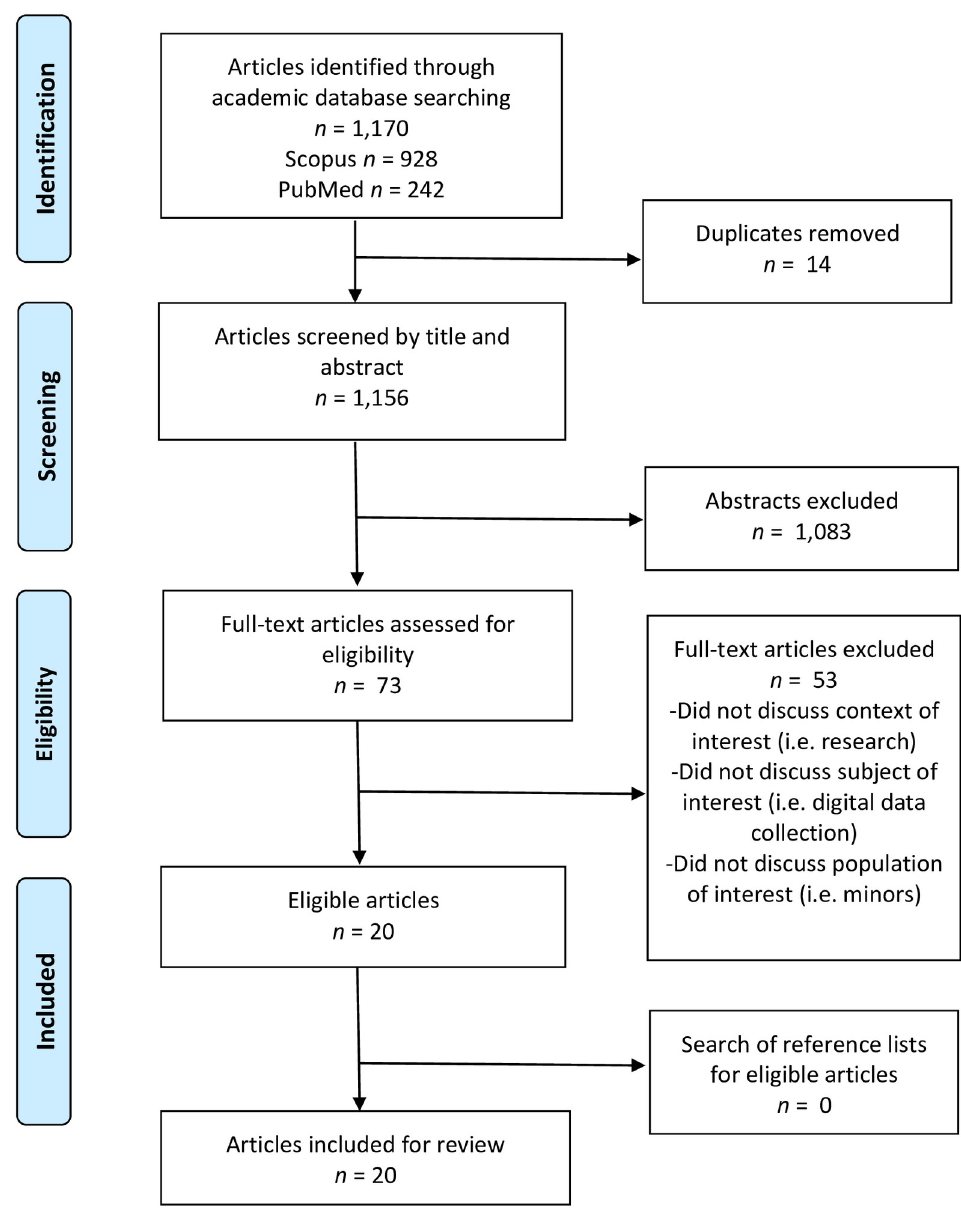
Fig 1. Search strategy and